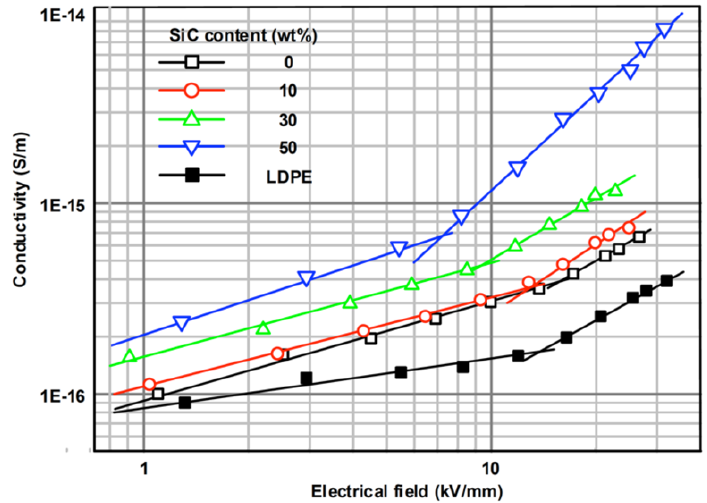
Figure 16. Relationship between conductivity and electric field for EPDM/SiC composites. © 2021